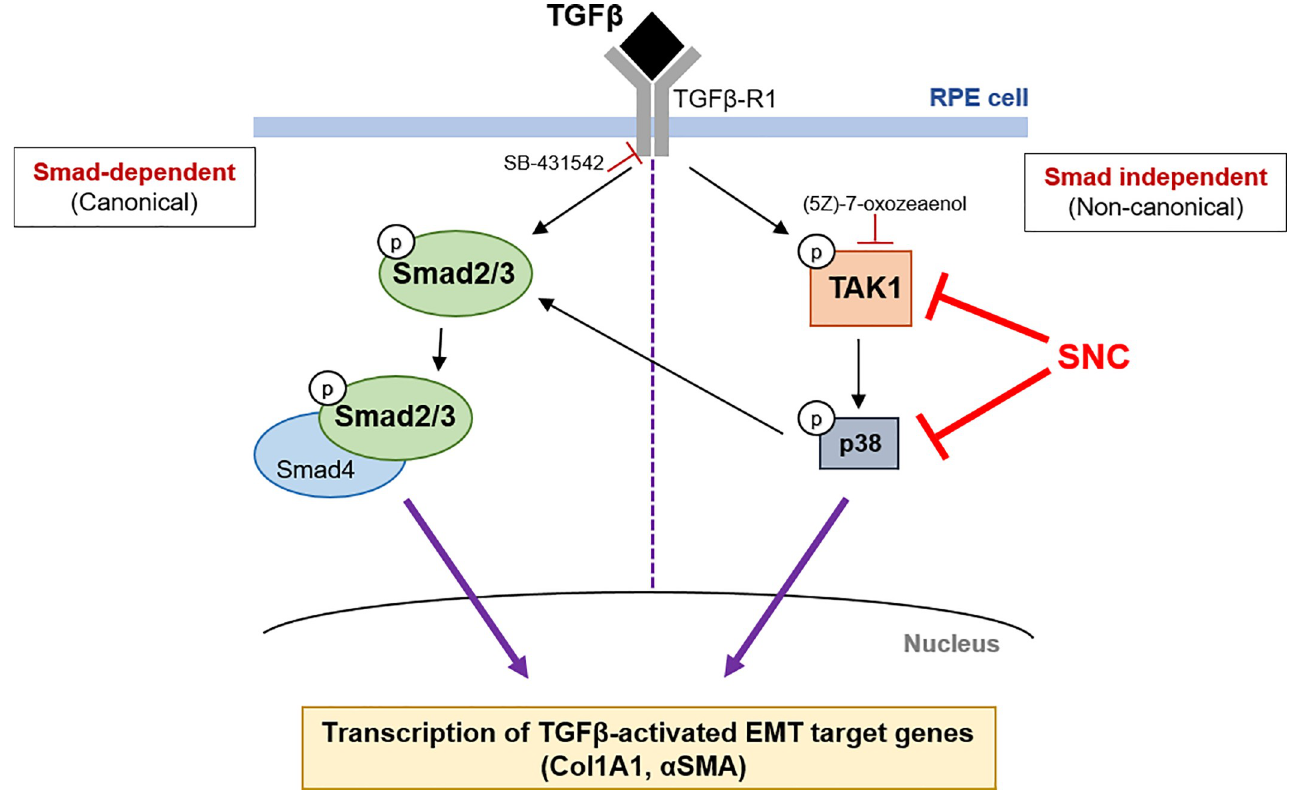
Fig 8. A model of salinomycin’s mechanism of action in RPE cells. Upon TGF β binding to the TGF β receptor, components of both Smad2/3 and TAK1 signaling pathways are rapidly phosphorylated and activated. TAK activation leads to the phosphorylation and activation of p38, which leads to a further increase in Smad2/3 phosphorylation and activation. Together, these signaling pathways lead to the transcription and activation of genes involved in EMT, including Col1A1 and α SMA. Salinomycin inhibits phosphorylation and downstream activities of TAK1 and p38, including the activation of Smad2/3 and ultimately EMT.